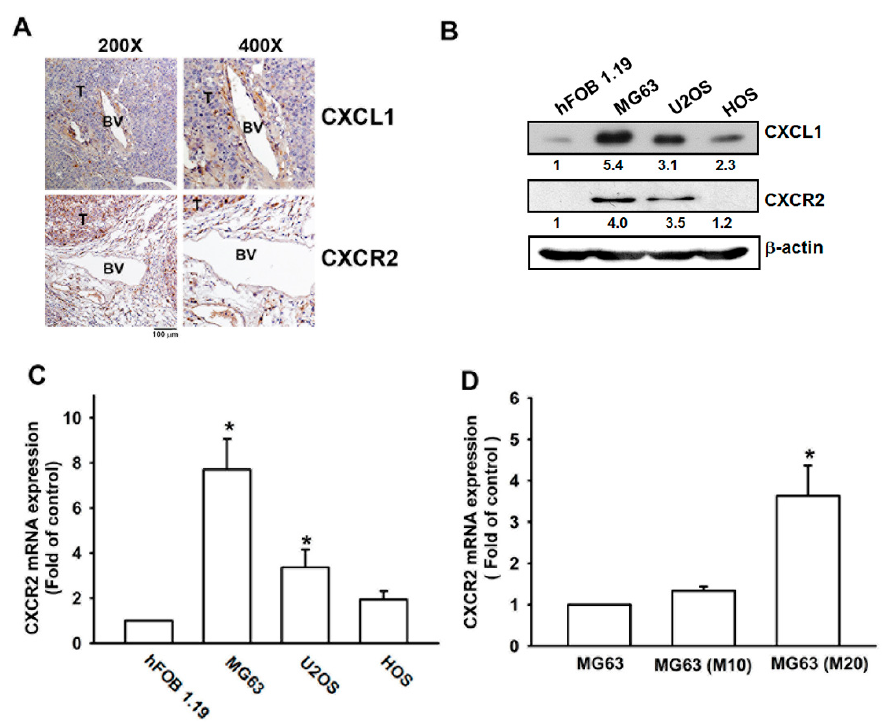
Figure 1. Expression of CXCL1 and CXCR2 in osteosarcoma lung metastasis. ( A ) The lung metastasis model was established by intravenous injection of MG63 osteosarcoma cells into CB17-SCID mice. Four weeks later, the lung specimens from sacrificed mice were stained with CXCL1 and CXCR2 antibodies, then photographed by optical microscope. T: tumor; BV: blood vessel. ( B , C ) Total cell lysate and RNA were extracted from hFOB1.19, MG63, U2OS and HOS cells, and CXCR2 expression was examined by Western blot and qPCR analysis. ( D ) The migration-prone MG63 cells were subjected to qPCR analysis to detect CXCR2 expression. Results are expressed as the mean ± SD. * p < 0.05 compared with the hFOB1.19 group.